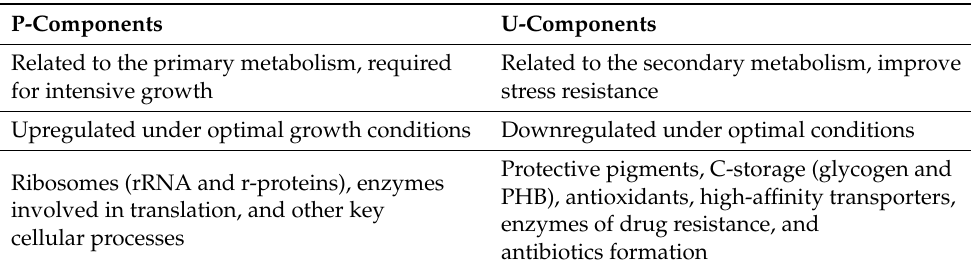
Table 2. Conditionally expressed cell constituents. P-Components U-Components Related to the primary metabolism, required for intensive